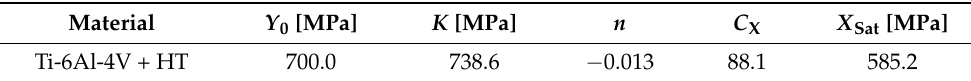
Table 1. Material parameters used in Swift isotropic hardening law coupled with the Armstrong– Frederick kinematic hardening law to describe the plastic behaviour of each Ti-6Al-4V.